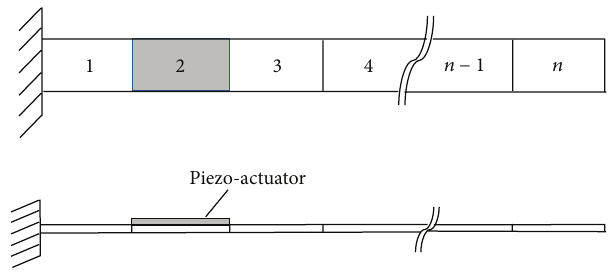
Figure 1: Finite element model of a piezo-actuated